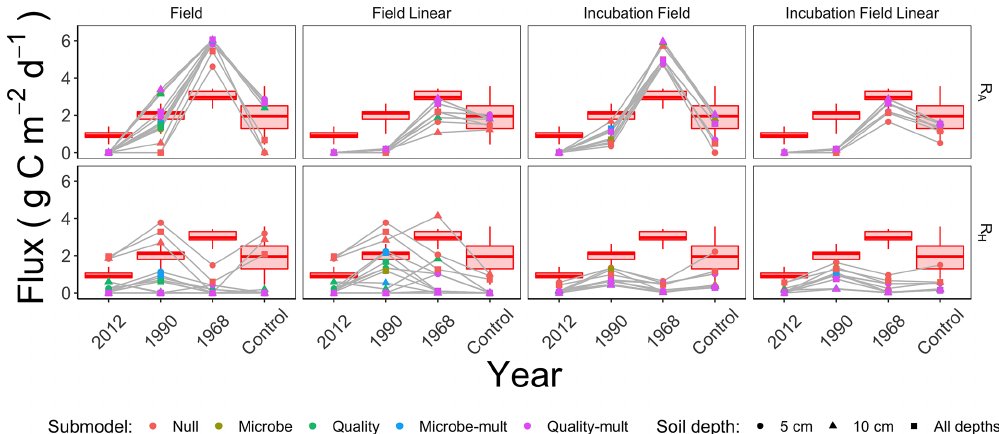
Figure 7. Median modeled fluxes of R A and R H from different parameter estimation approaches (field, field linear, incubation field, incu- bation field linear), soil depth data used for parameter optimization (5cm, 10cm, or both depths together), and submodels (Null, Microbe, Quality, Microbe-mult, and Quality-mult). The grey lines are used as a guide to show the chronosequence trend for a particular parameter estimation approach and soil depth. The box plot shows measured ranges of R S at each site in the chronosequence.